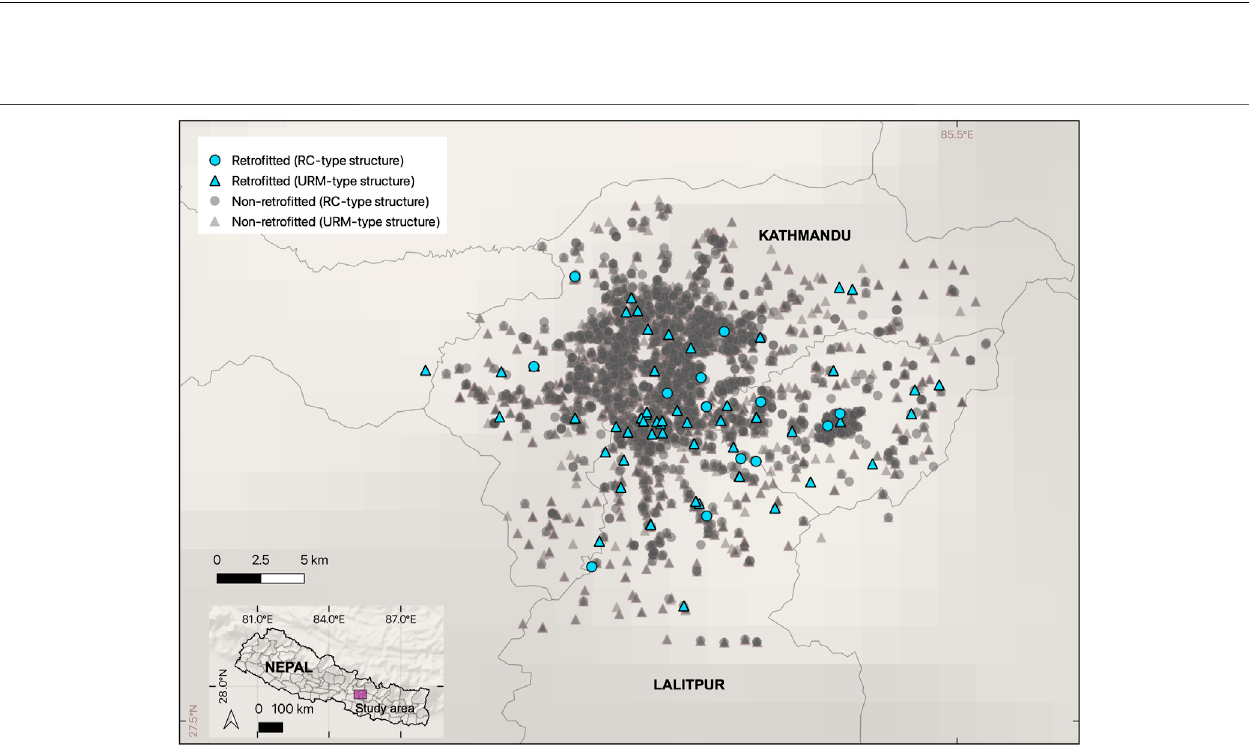
FIGURE 2| A map of the school building database used in the analysis. Shown are the buildings ’ retro fi t state and structure type assurveyed in 2013 by the Open Data for Resilience Initiative and the Government of Nepal.